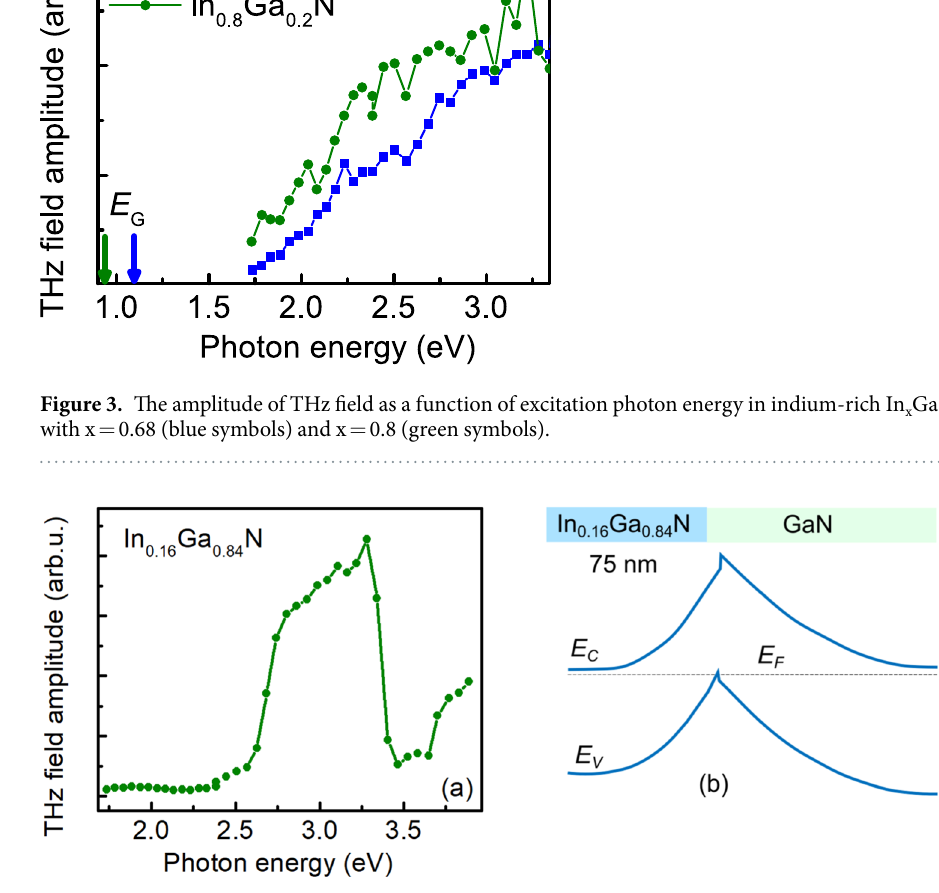
Figure 4. THz emission intensity dependence on excitation photon energy ( a ) and the modelled energy bands ( b ) in In 0.16 Ga 0.84 N